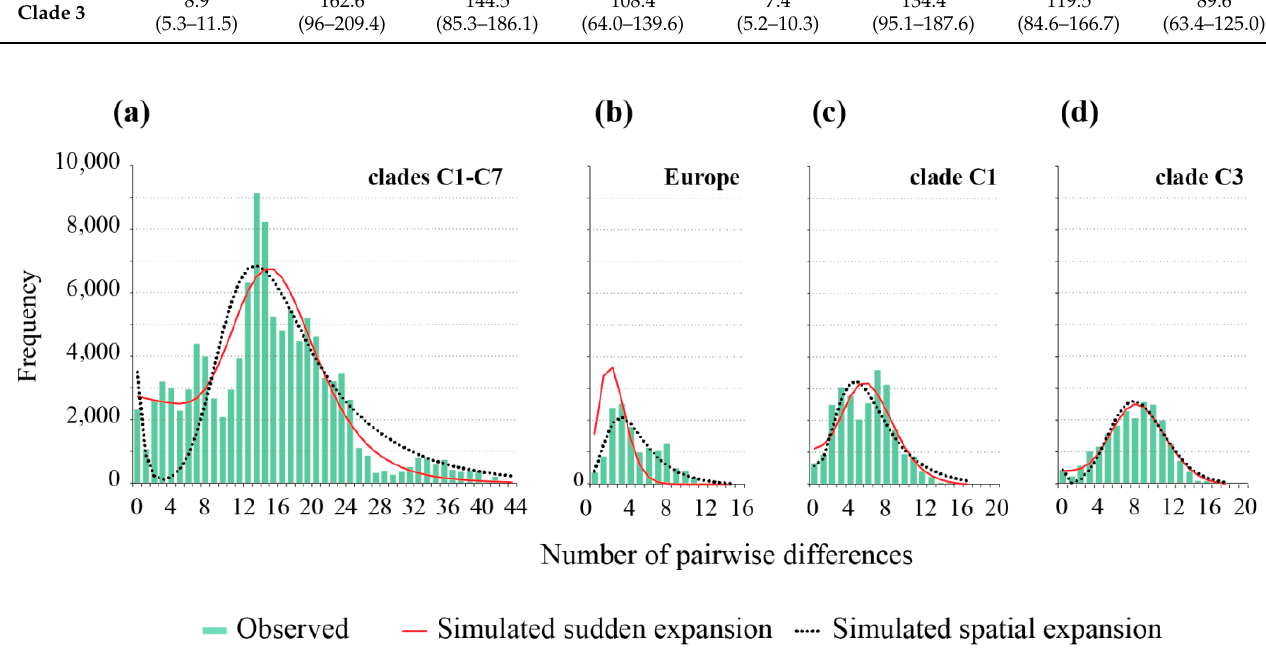
Figure 4. Reconstructed mismatch distributions (MMD) of A. agrarius in Eurasia ( a ), European clade C1 ( b ), clade C1 ( c ) and clade C3 ( d ), with the observed (histograms) and simulated distributions for the spatial (dotted black lines) and sudden (solid red lines) expansion models.